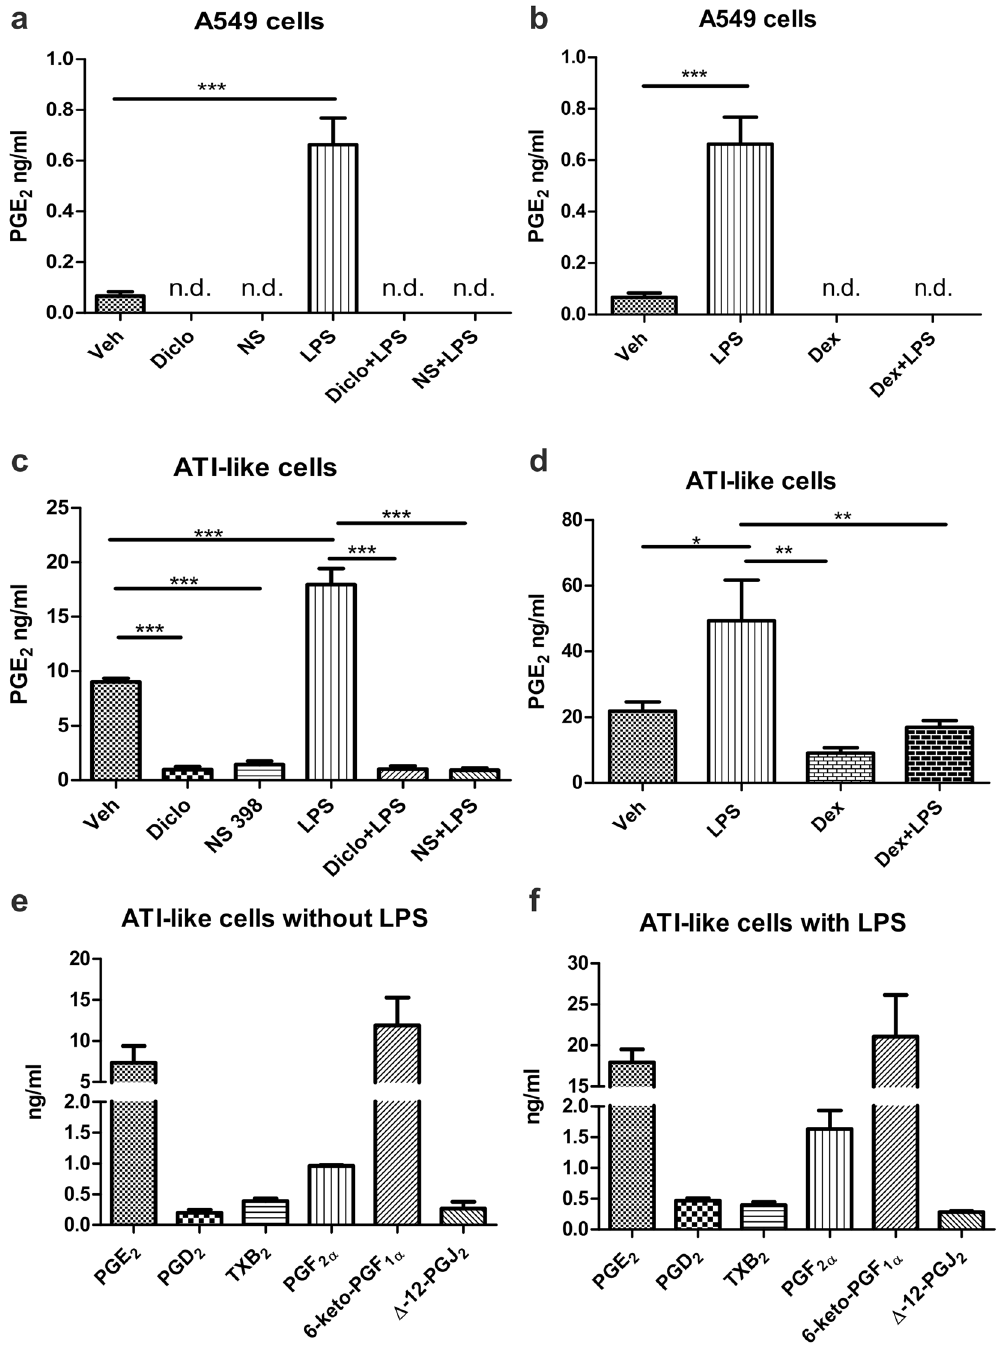
Figure 1. A549 cells as well as primary mouse ATI-like cells release PGE 2 . ( a , b ) A549 cells were kept in culture for 3 days. On the third day, cells were pretreated ( a ) with either diclofenac (diclo, 10 µ M), NS398 (1 µ M), or vehicle (Veh) for 20 min; ( b ) dexamethasone-pretreatment (dexa 1 µ M) was performed for two days. Thereafter, cells were stimulated with LPS (10 µ g/ml) or vehicle (Veh). ( c,d,e,f ) Primary ATI-like cells were isolated from BALB/c mice and kept in culture for 6 days. After 6 days, medium was changed and cells were pretreated with ( c ) either diclofenac (diclo, 10 µ M), NS398 (1 µ M), or vehicle (Veh) for 20 min; ( d ) dexamethasone-pretreatment (dexa 1 µ M) was performed for three days. Thereafter, cells were stimulated with LPS (10 µ g/ml) or vehicle (Veh). n.d. not detectable. ( e,f) Primary mouse ATI-like cells in addition to PGE 2 secrete a broad spectrum of prostaglandins under both resting and LPS-stimulated conditions as determined by mass spectrometry (n = 3). Statistical analysis was performed using (a,b ) two-tailed t-test for A549 (n = 6) or ( c,d ) One Way ANOVA and Bonferroni’s post-hoc test for ATI-like cells (n = 5), * p < 0.05; ** p < 0.01; *** p <